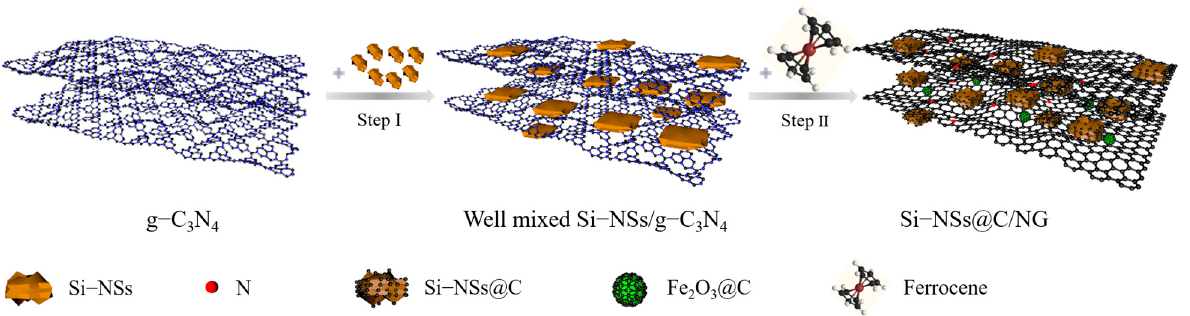
Figure 4. Schematic illustration of the synthesis process of Si–NSs@C/NG.